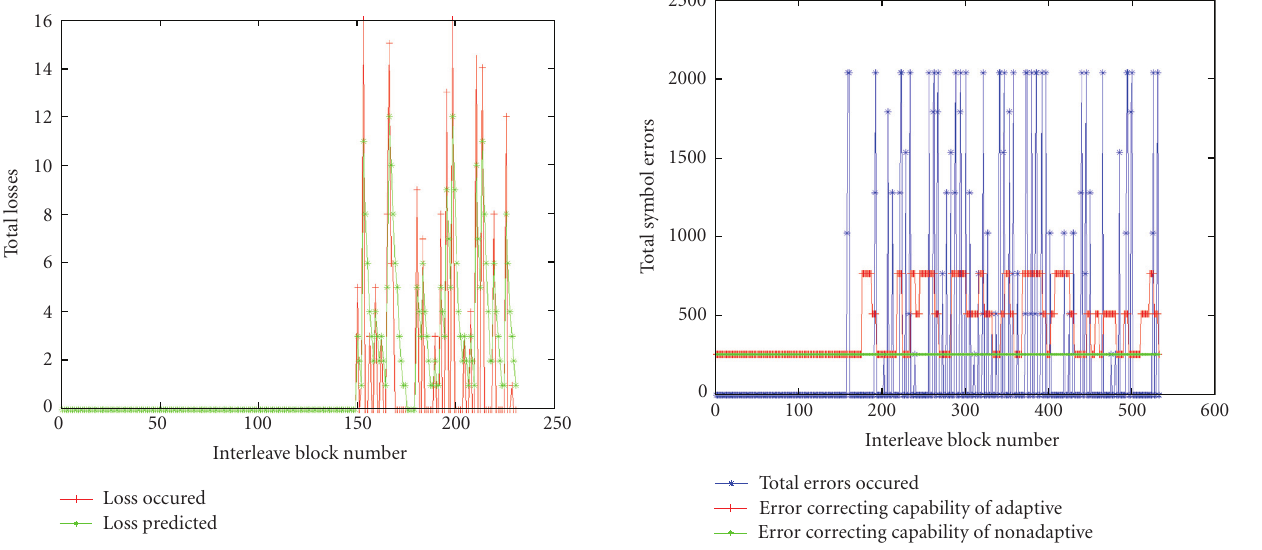
Figure 10: Performance of feedback for “ all ” sequence at 32 kbps, random delay 0.028, bu ff er size 175, packet size 256, span 8, PL rate